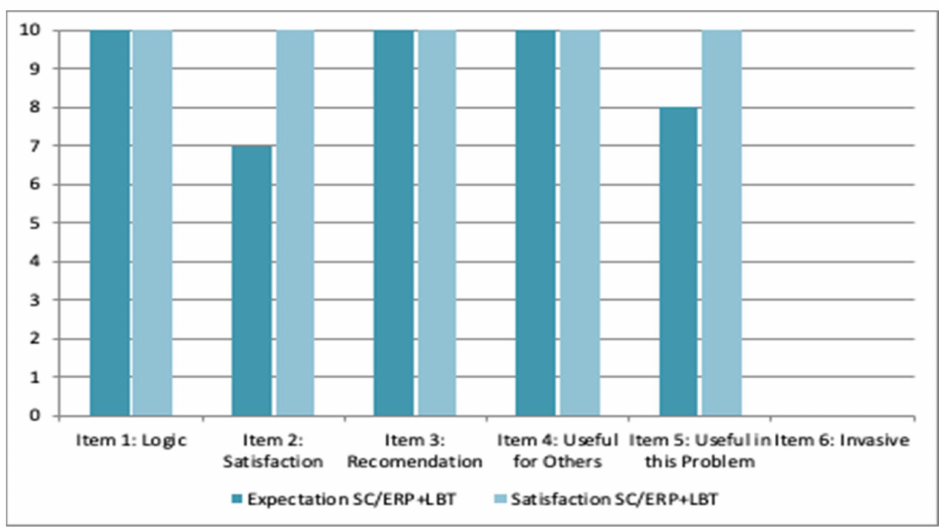
Figure 6. Expectation and satisfaction with the SC/ERP + LBT-based ICT system by patient 2.